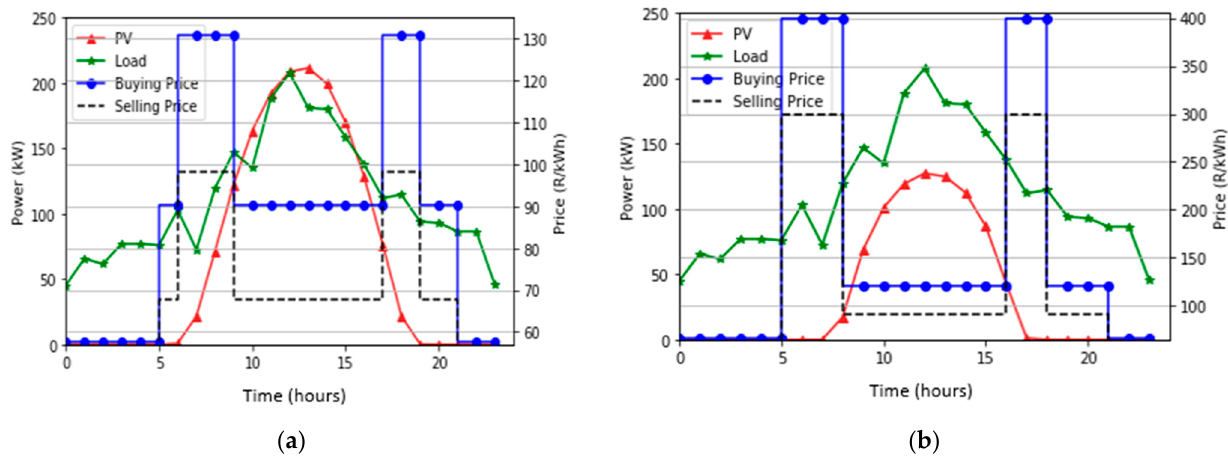
Figure 2. Input data; ( a ) Summer solar PV power, load profile, and summer grid prices. ( b ) Winter solar PV power, load profile, and winter grid prices.